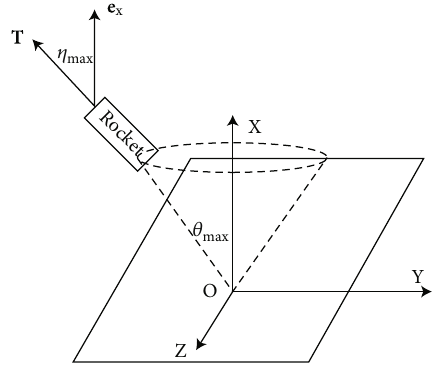
Figure 1: Inertial reference